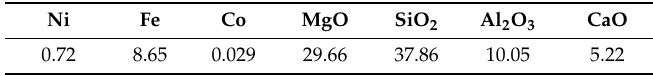
Table 1. Main chemical composition of garnierite laterite ore (%).